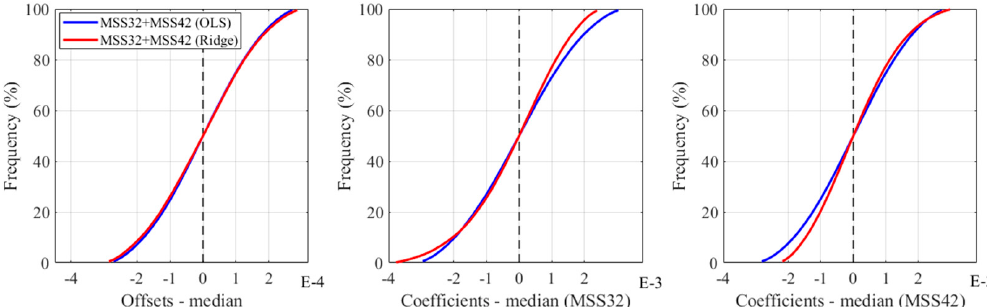
Figure 8. Cumulative distributions of the coefficients for the bivariate models of Landsat 4, including the offset (left), the coefficient of MSS32 (center), and the coefficient of MSS42 (right). The probabilities were estimated according to 10,000 times K-fold (K = 5) cross-validation tests. To show the distribution difference, the coefficients were shifted by subtracting the median values respectively. For OLS regression model and ridge model, the median offset estimates are –0.0065 and –0.0051, the median estimates of MSS32 are 0.7724 and 0.7023, and the median estimates of MSS42 are 0.3226 and 0.3767 respectively, as shown in Table 4.